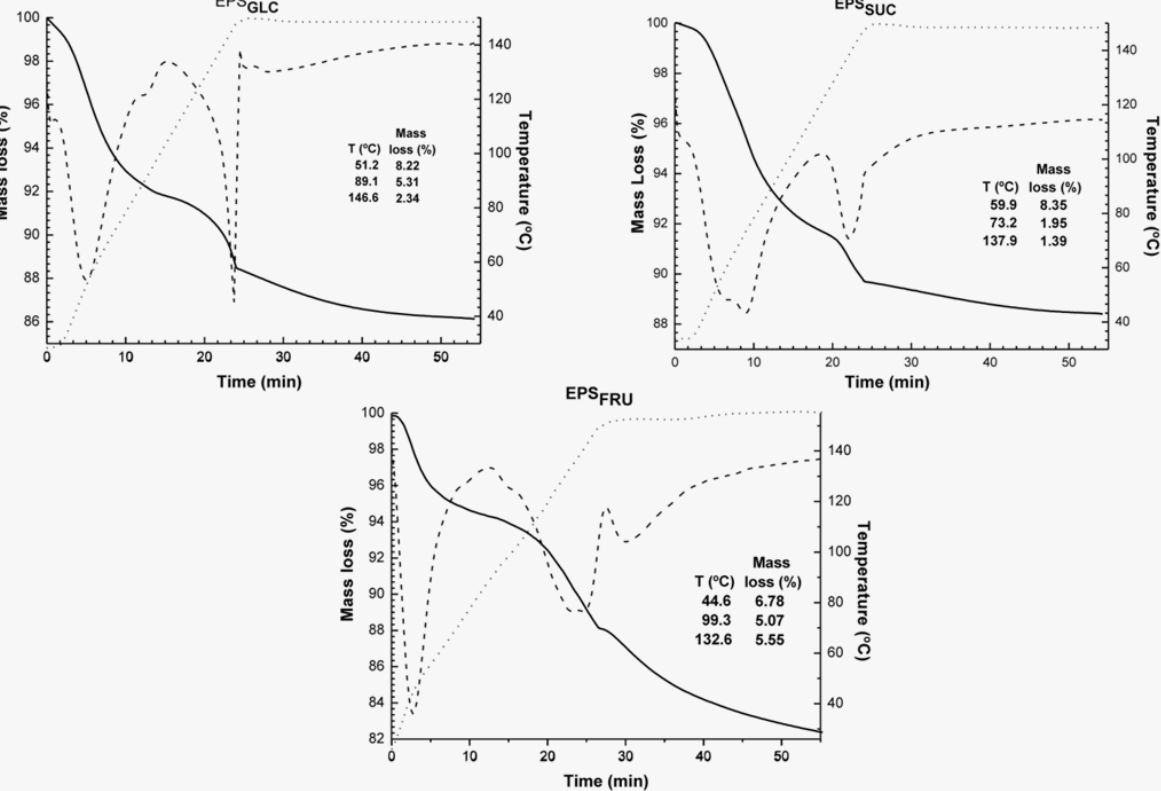
, EPS and EPS GLC SUC FRU